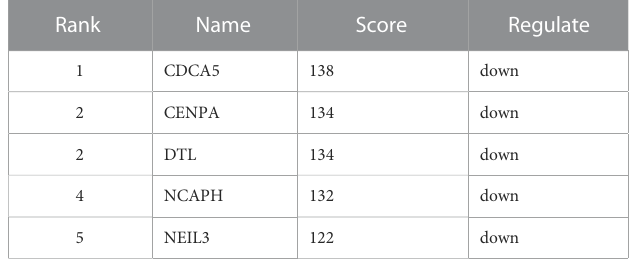
TABLE 2 Top 5 in PPI network of interactive genes ranked by Maximum Climate Centrality (MCC) method.